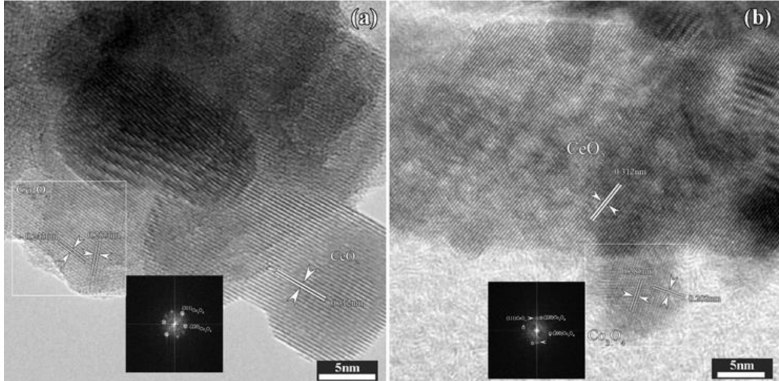
Figure 3. HR-TEM micrographs of the CeO 2 -P ( a ) and CeO 2 -H ( b ) specimens. As insets, FFT images taken at the white marked area are present for the two different cases, CeO 2 -P ( a ) and CeO 2 -H ( b ) samples,